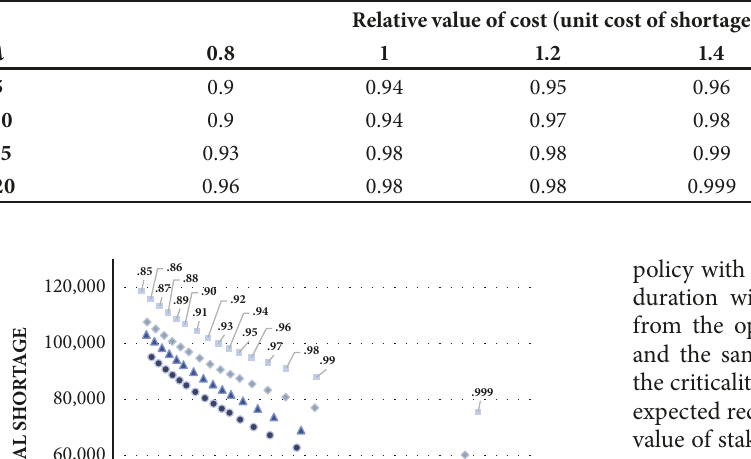
Table 4: Optimal CSL for varying ratios of shortage and inventory costs under different disruption patterns as defined by the expected number of recall disruptions ( 𝜆 ).